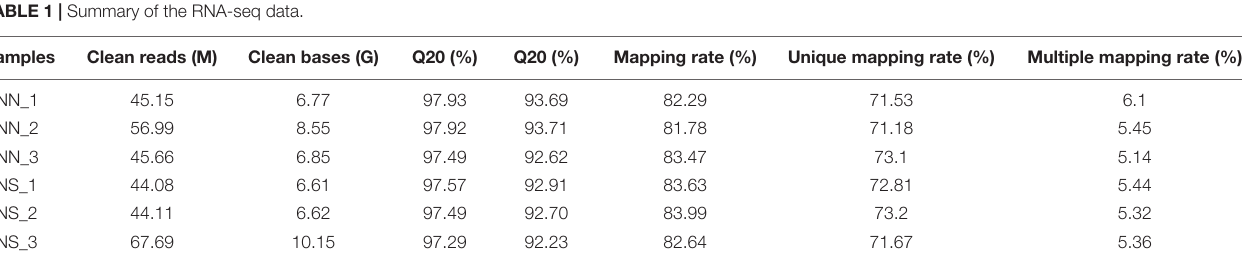
FIGURE 1 | (A) Line plot showing the variation of sea surface temperature (SST) from April 2019 to 2020, representing the abalones cultivation environment. (B) Bar plot showing the shell length data of H. discus hannai from the CNN population and CNS population. (C) Bar plot showing the total weight data of H. discus hannai from the CNN and CNS populations. The blue bar indicates CNN population and the red bar indicates CNS. * P < 0.05 between two groups. TABLE 1 | Summary of the RNA-seq